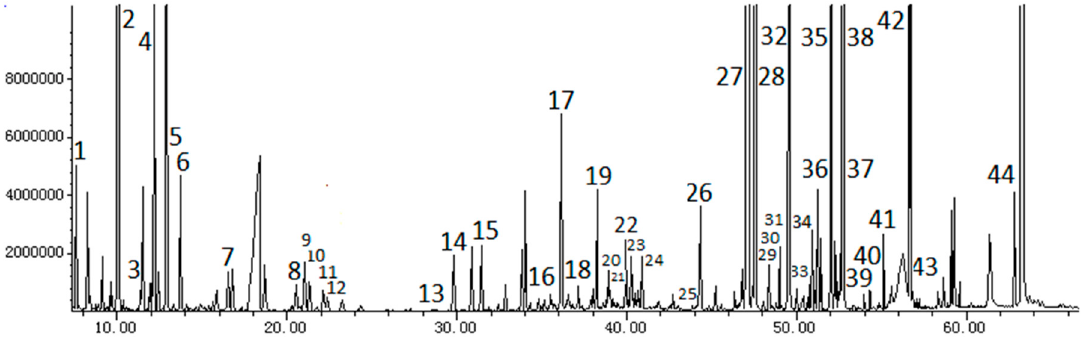
Figure 1. Total ion chromatogram (TIC) profile of metabolites in rat plasma by gas chromatography coupled with mass spectrometry (GC-MS). Table 1. The plasma metabolites of three groups of control, model and Simiaowan (SMW) identified